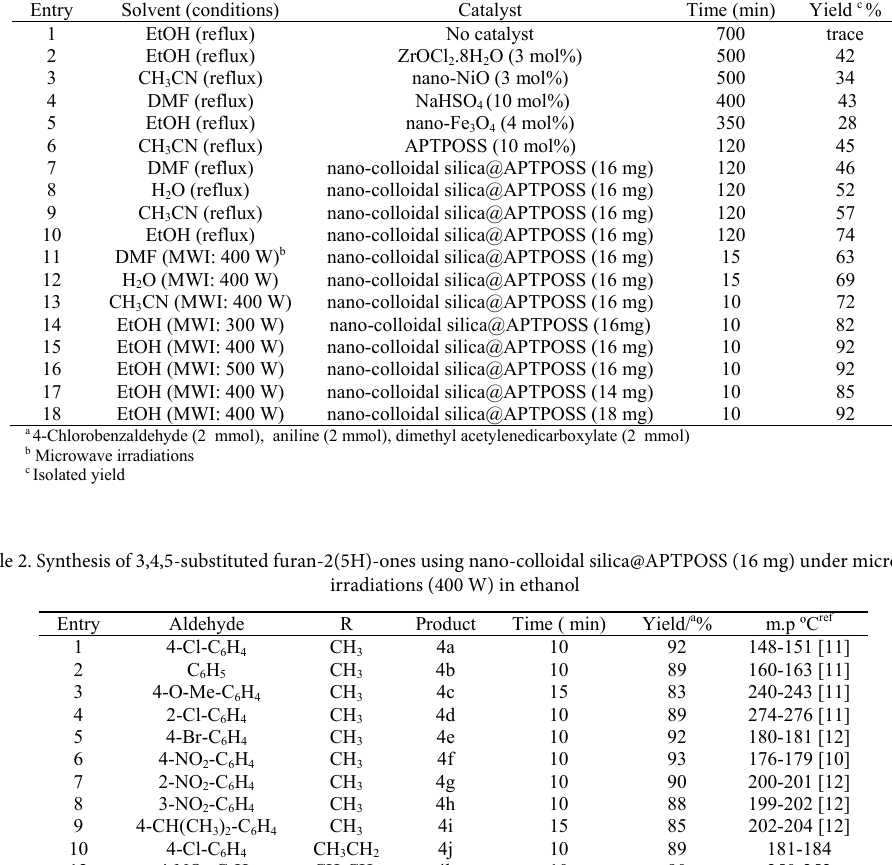
17 Nanochem Res 4(1): 11-19, Winter and Spring 2019